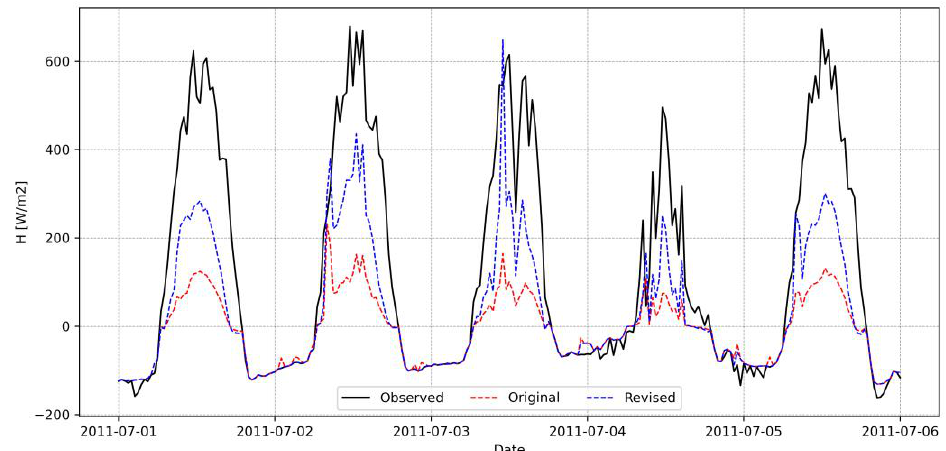
Figure 9. Variations in the observed and simulated sensible heat flux by the original and the revised parameterization at 30 min temporal resolution over five days at the FR-Pue site.